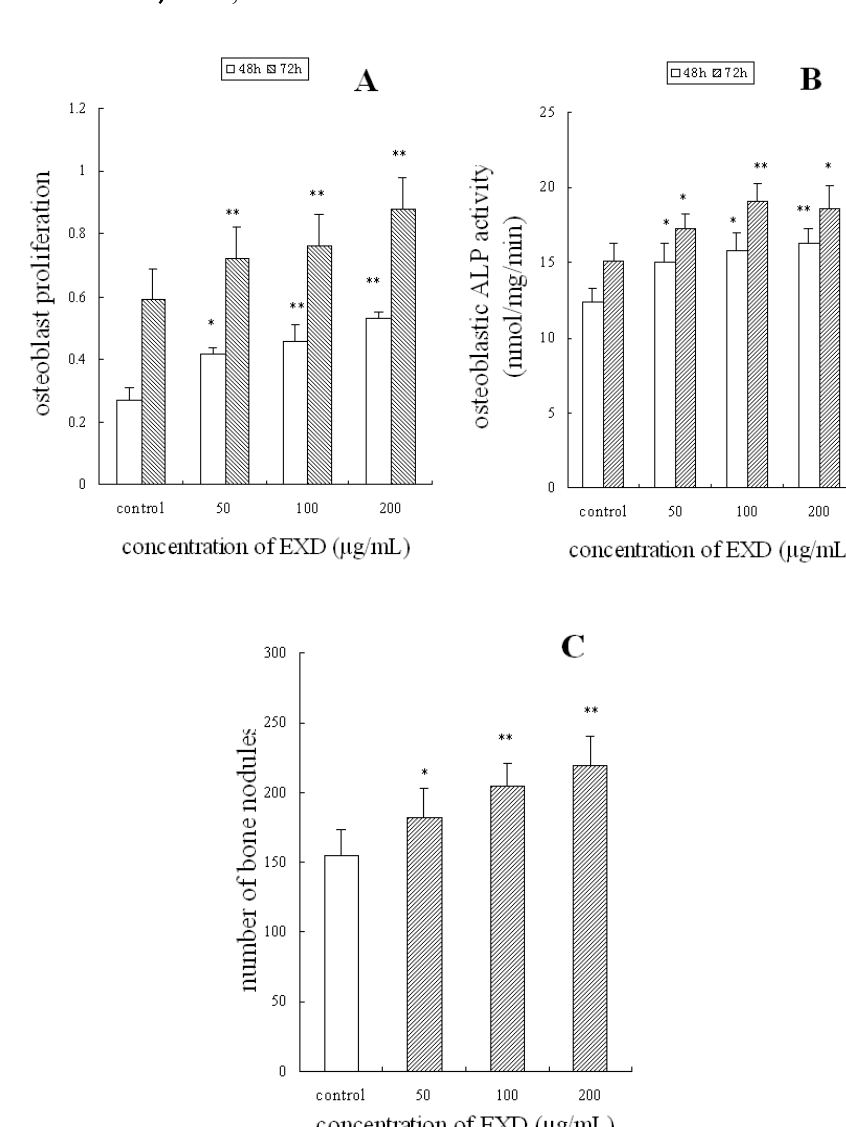
Figure 1. Effects of EXD on osteoblastic UMR-106 cells. Osteoblastic UMR-106 cells were treated with EXD at concentrations of 50, 100, or 200 μ g/mL for 48 h and 72 h (proliferation and ALP activity) or 14 days (formation of bone nodules). A: osteoblast proliferation; B: osteoblastic ALP activity; C: formation of bone nodules. * P < 0.05; ** P < 0.01 compared with control , n = 8,